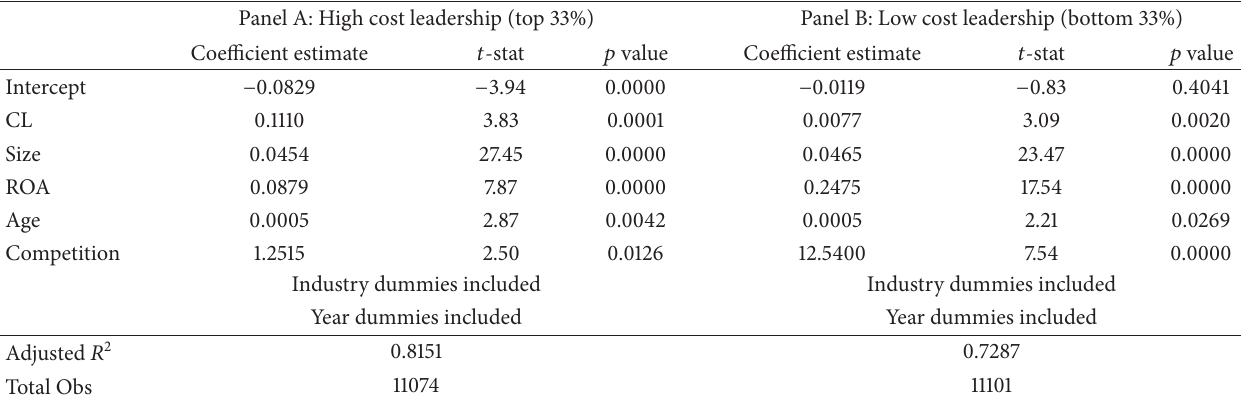
Table 5: Cost leadership strategy and production efficiency. Low cost leadership firms compared to high cost leadership firms. Dependent variable: production efficiency.